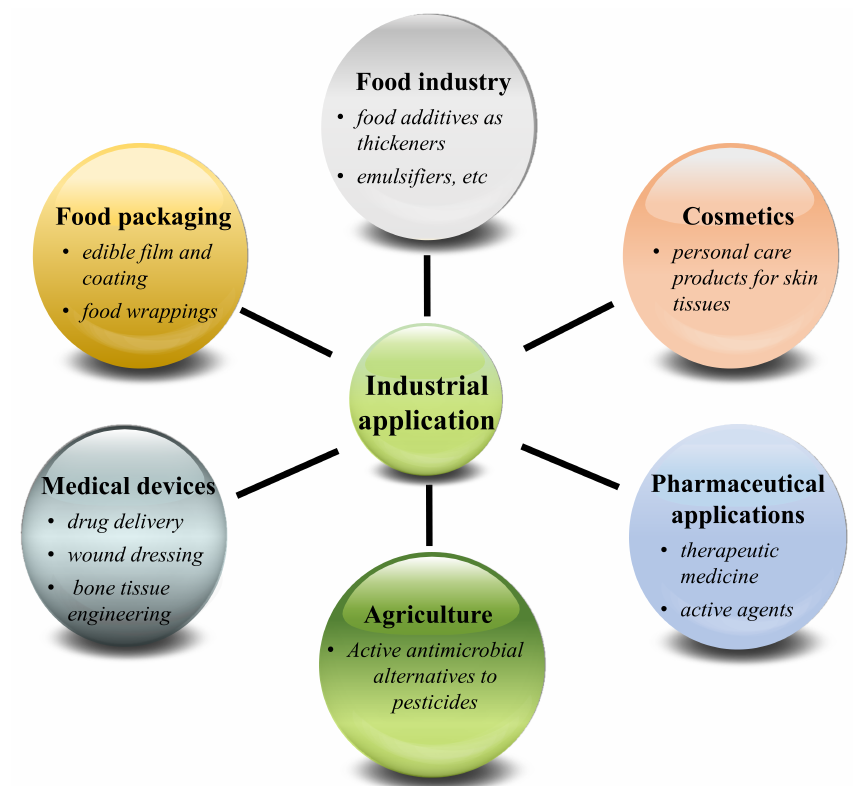
Figure 2 Figure 2. Major applications of ulvan polysaccharides in various industrial